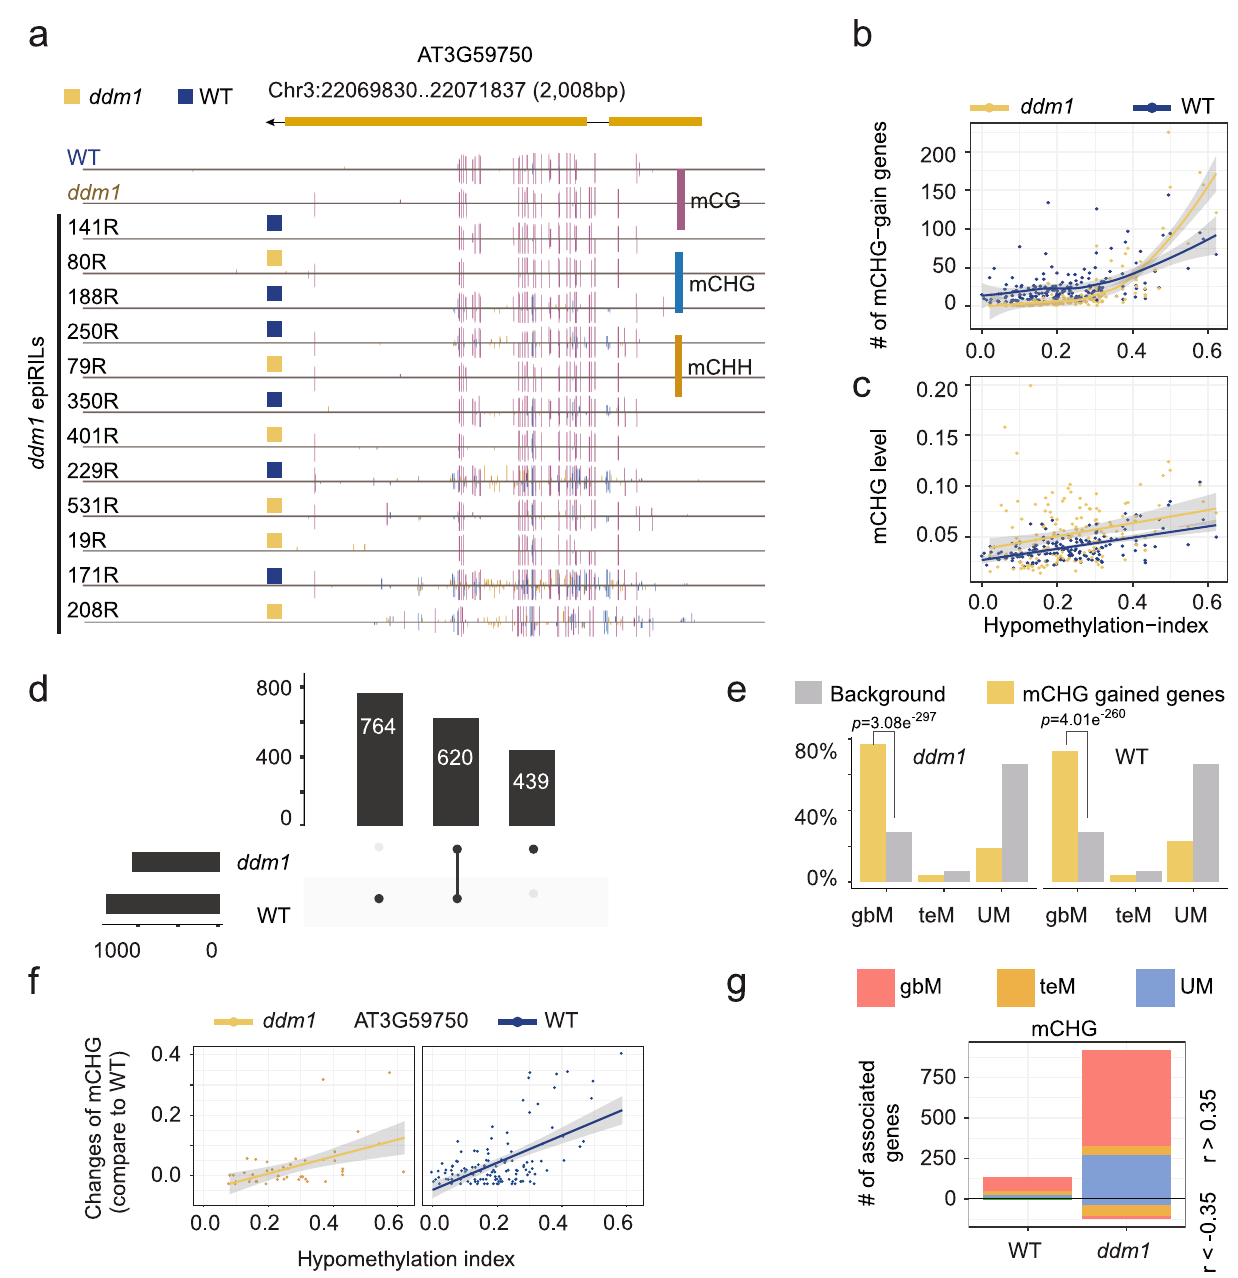
Fig. 3 Global hypomethylation leads to ectopic activity of CMT3 at genes present within wild-type and ddm1 haplotypes. a Genome browser view of a representative gene AT3G59750, in which non-CG methylation was observed in epiRILs with either wild-type or ddm1 derived haplotypes. b Correlation between hypomethylated genome and the number of gbM genes that gain CHG methylation. Genes inherited from WT (blue dots) and ddm1 (yellow dots) parents were calculated separately for each epiRIL. Gray area shows 95% con fi dence level interval for predictions (shown by lines) from a loess regression model. c Correlation between hypomethylated genomes and the average accumulated CHG methylation level on mCHG-gain genes. Gray area shows 95% con fi dence level interval for predictions (showing by lines) from a linear regression model. d A union set of total mCHG-gain genes from all epiRIL lines. It shows the number of mCHG-gain genes from each haplotype type as well as those shared by both haplotypes. e An enrichment analysis using Fisher ’ s Exact test shows that mCHG-gain genes that either from ddm1 (left) or WT haplotypes (right) are enriched in gbM genes. Yellow bars show the ratio of each type of genes with ectopic mCHG. Gray bars show the ratio of each type of genes in comparison with all coding genes. p- value is based on one-sided test with alternative hypothesis that odds ratio is greater than 1. f Genome-wide association of methylation level changes (difference of value compared to WT) at an example gene compared to its hypomethylation index. An example of positive correlation is shown for AT3G59750. For each gene, the epiRILs were grouped based on haplotypes, either WT (blue) or ddm1 (yellow) derived haplotypes. Gray area shows 95% con fi dence level interval for predictions (showing by lines) from a linear regression model. g Correlation test in f was applied for all genes. The bar plot shows the number of genes with CHG methylation level changes strongly correlated with the hypomethylation index (with Pearson correlation coef fi cient either >0.35 (above the line) or < − 0.35 (below the line)). The number of associated genes is calculated separately based on haplotypes (either WT or ddm1 derived haplotypes) and gene type (gbM, teM and UM). Source data underlying Figs. 3b, 3e, and 3g are provided as a Source Data fi